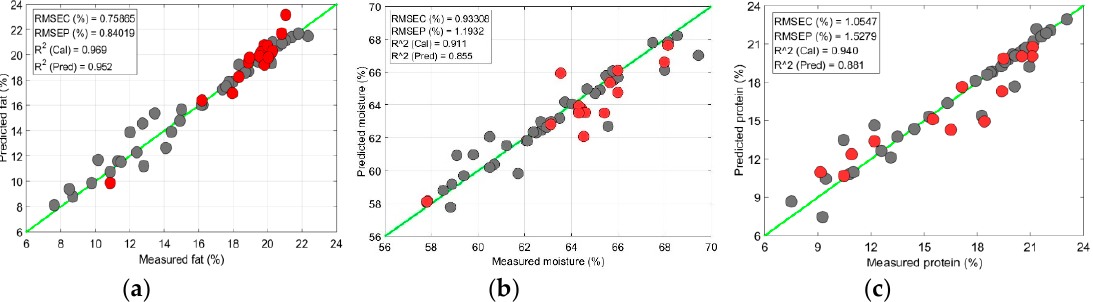
Figure 9. Chemical-component prediction in turkey from SVR model: ( a ) Prediction plot of fat content; ( b ) Prediction plot of moisture content; ( c ) Prediction plot of protein content.